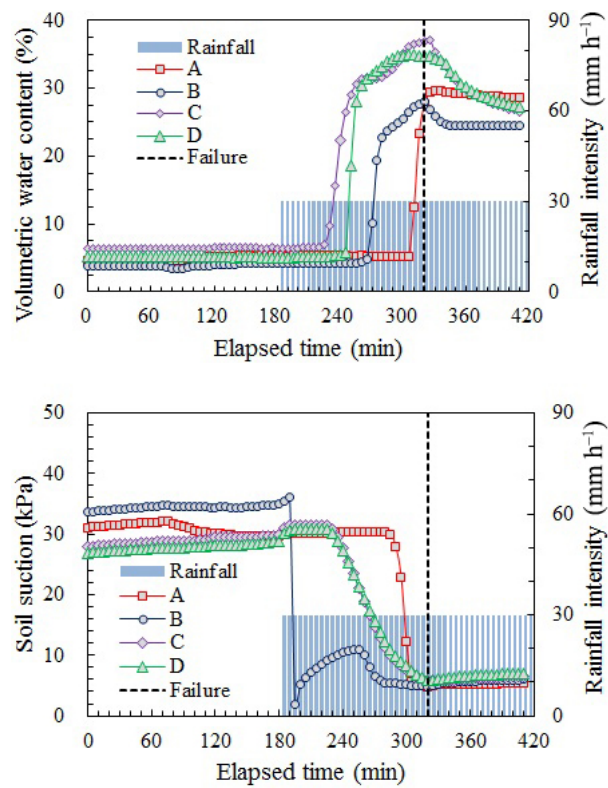
Figure 8. Variation of volumetric water content and soil suction in the model slope of 70 ◦ inclination: (a) volumetric water content, (b) soil